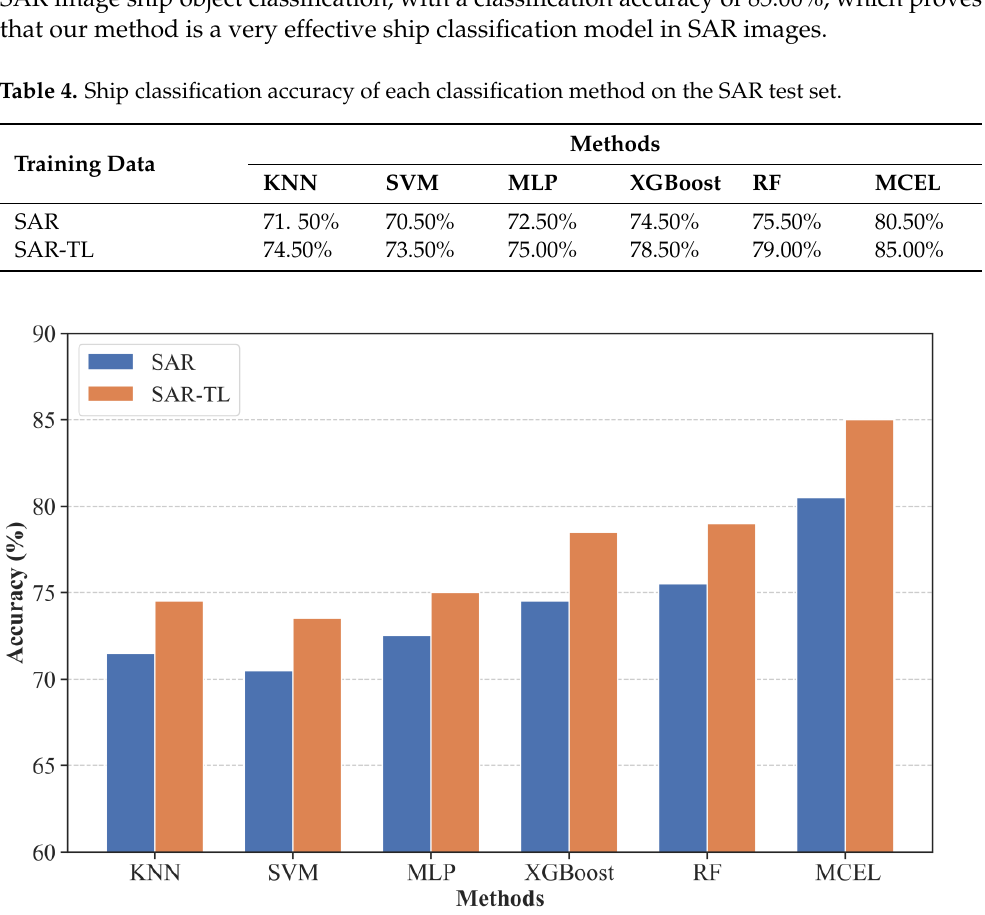
Figure 12. Ship classification accuracy of each classification method on the SAR test set.